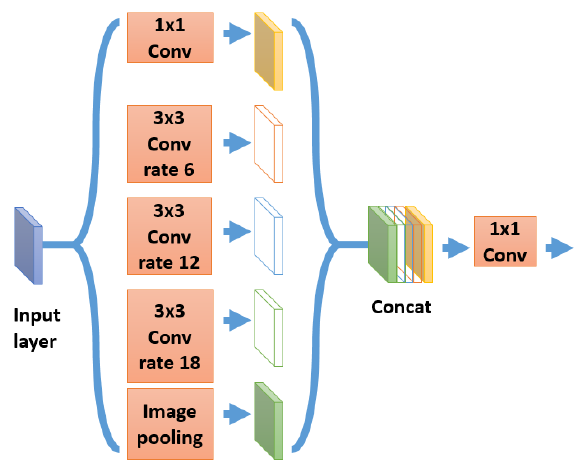
Figure 8. Atrous Spatial Pyramid Pooling Module (ASPP).